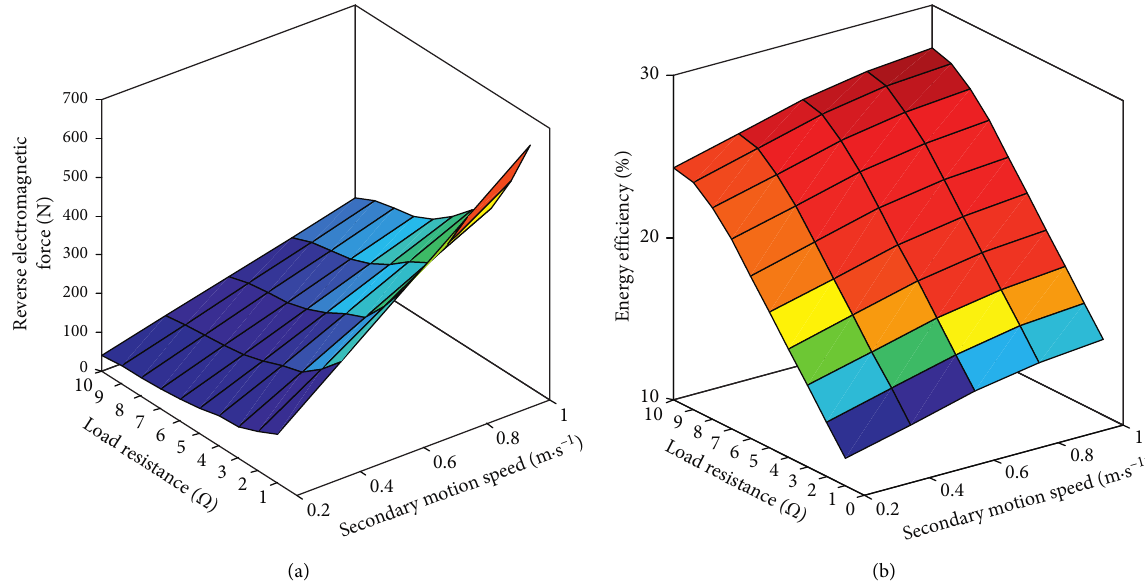
Figure 15: Back electromagnetic force and energy feedback efficiency of actuator. (a) Back electromagnetic force. (b) Energy feedback efficiency.